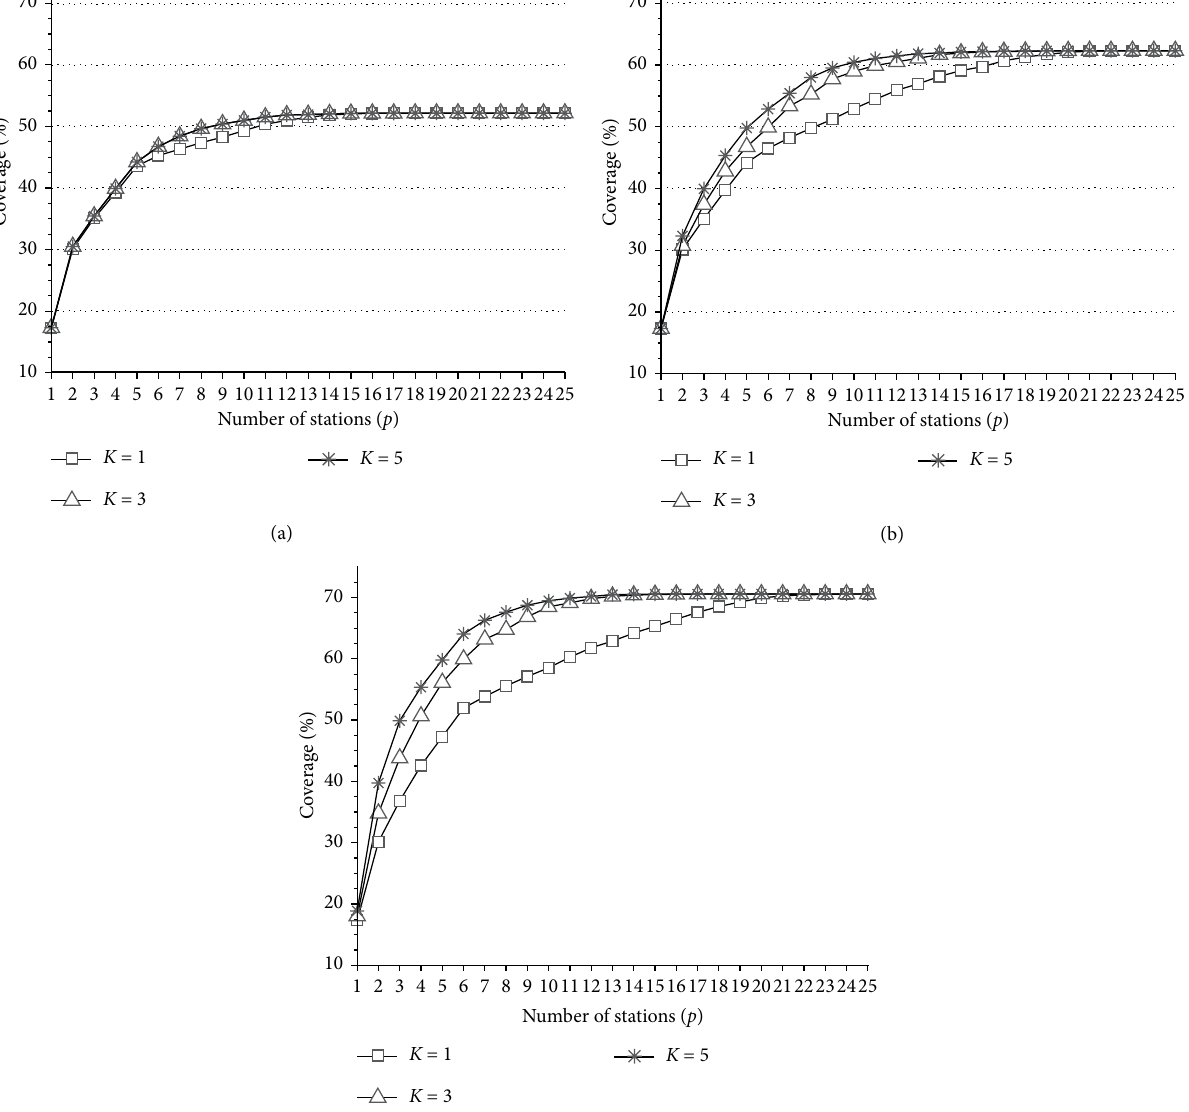
Figure 6: Tradeoff between number of stations and coverage for different number of SNDF paths. (a)